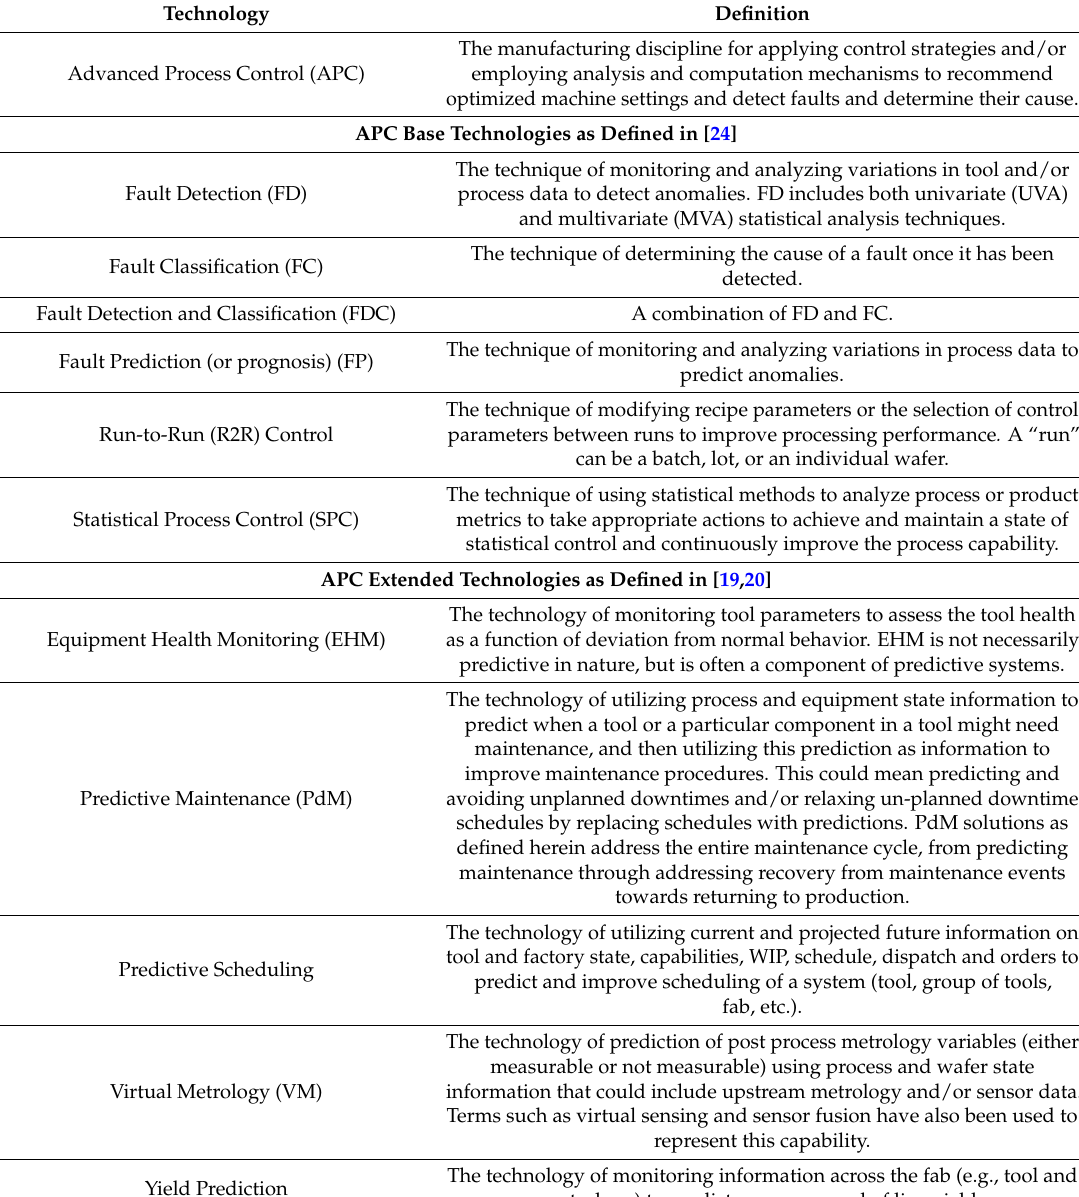
Table 1. Definitions of Advanced Process Control (APC) and APC extended